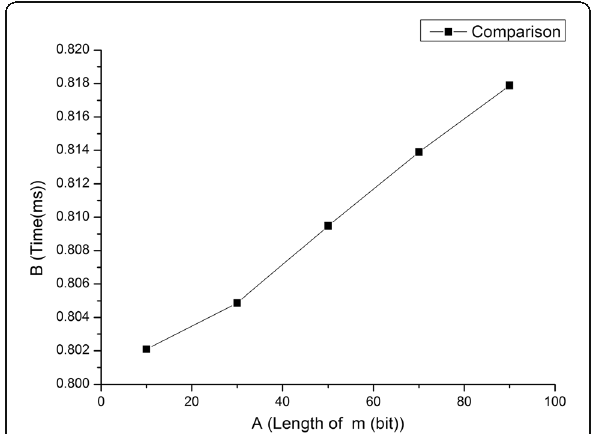
Fig. 3 Time cost in comparison phase